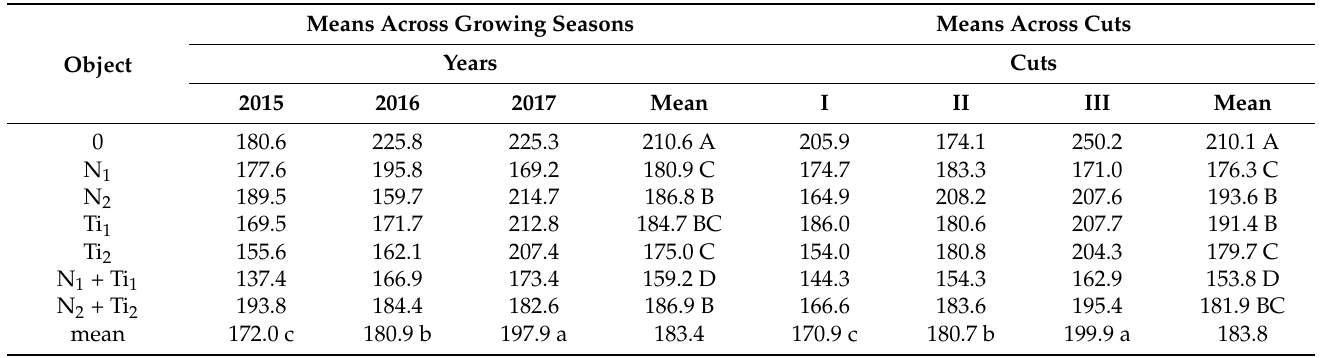
Different lowercase letters in the same row or different uppercase letters in the same column indicate significant differences between treatments. 0—control; N 1 —ammonium nitrate at a dose of 80 kg N ha − 1 ; N 2